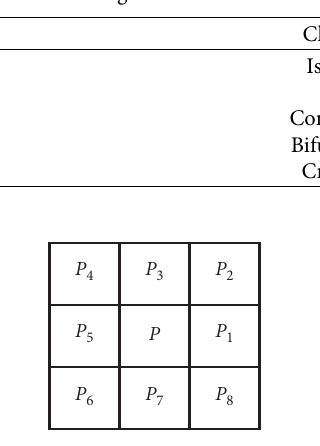
Table 2: Crossing number characteristics.